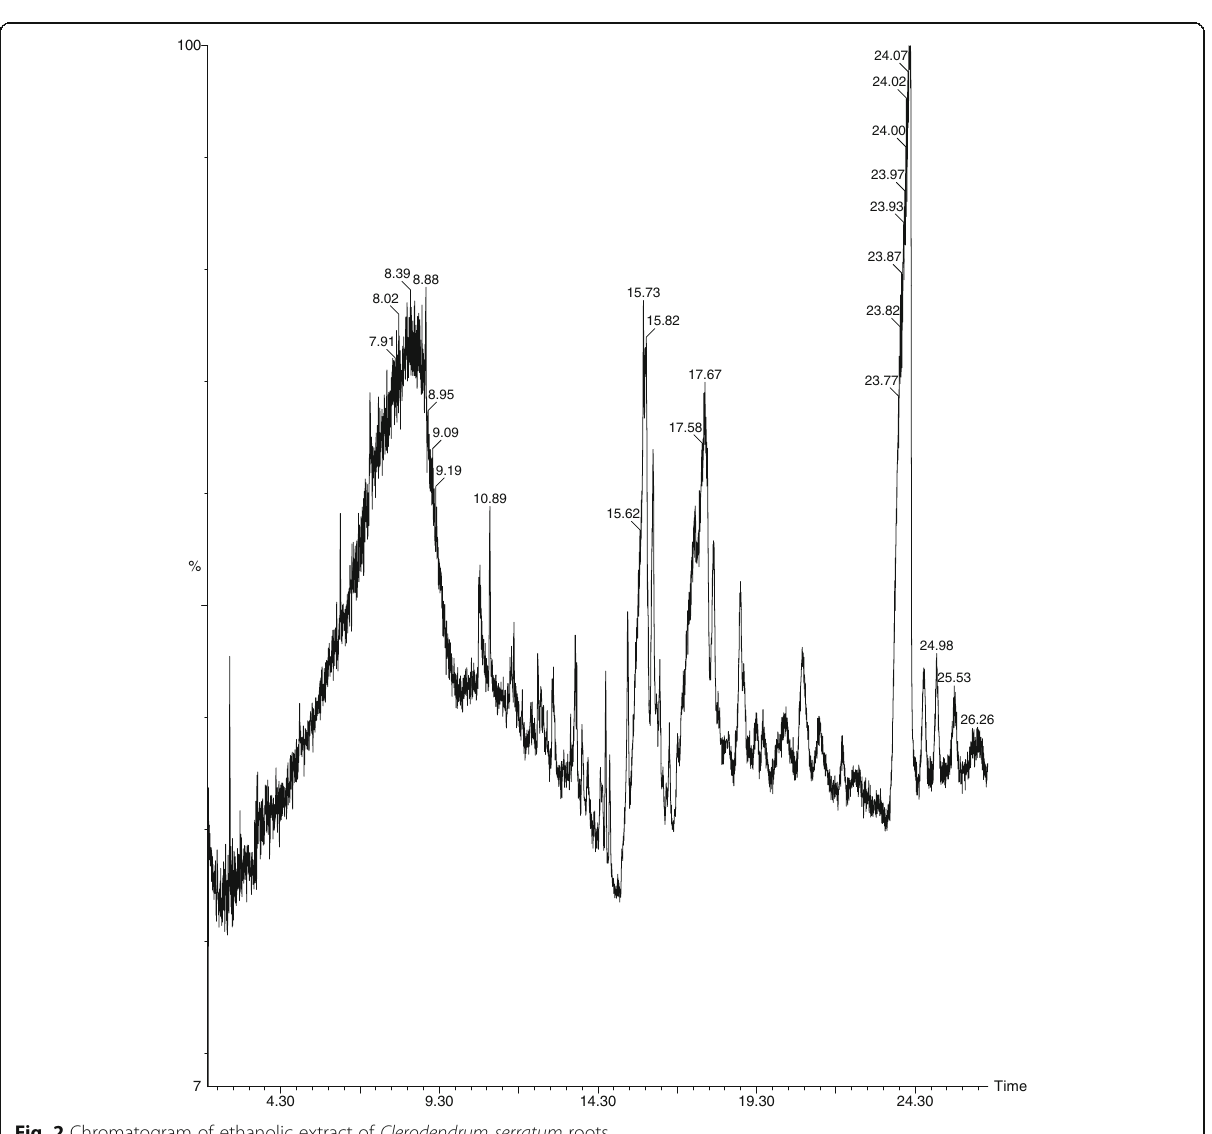
Fig. 2 Chromatogram of ethanolic extract of Clerodendrum serratum